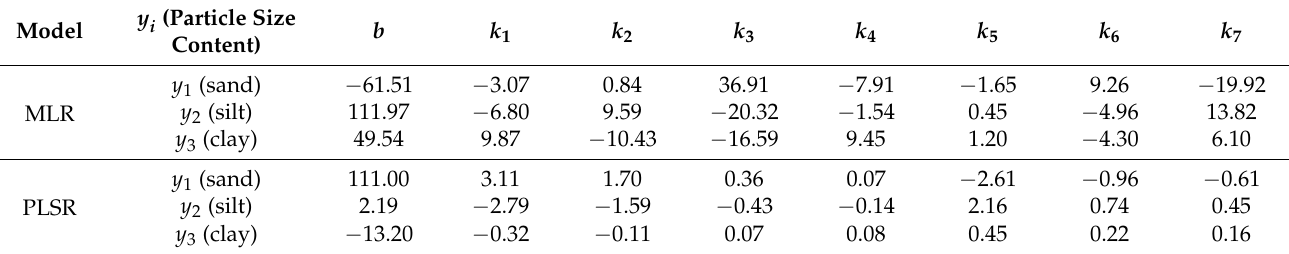
Table 4. Regression equation coefficient of MLR and PLSR